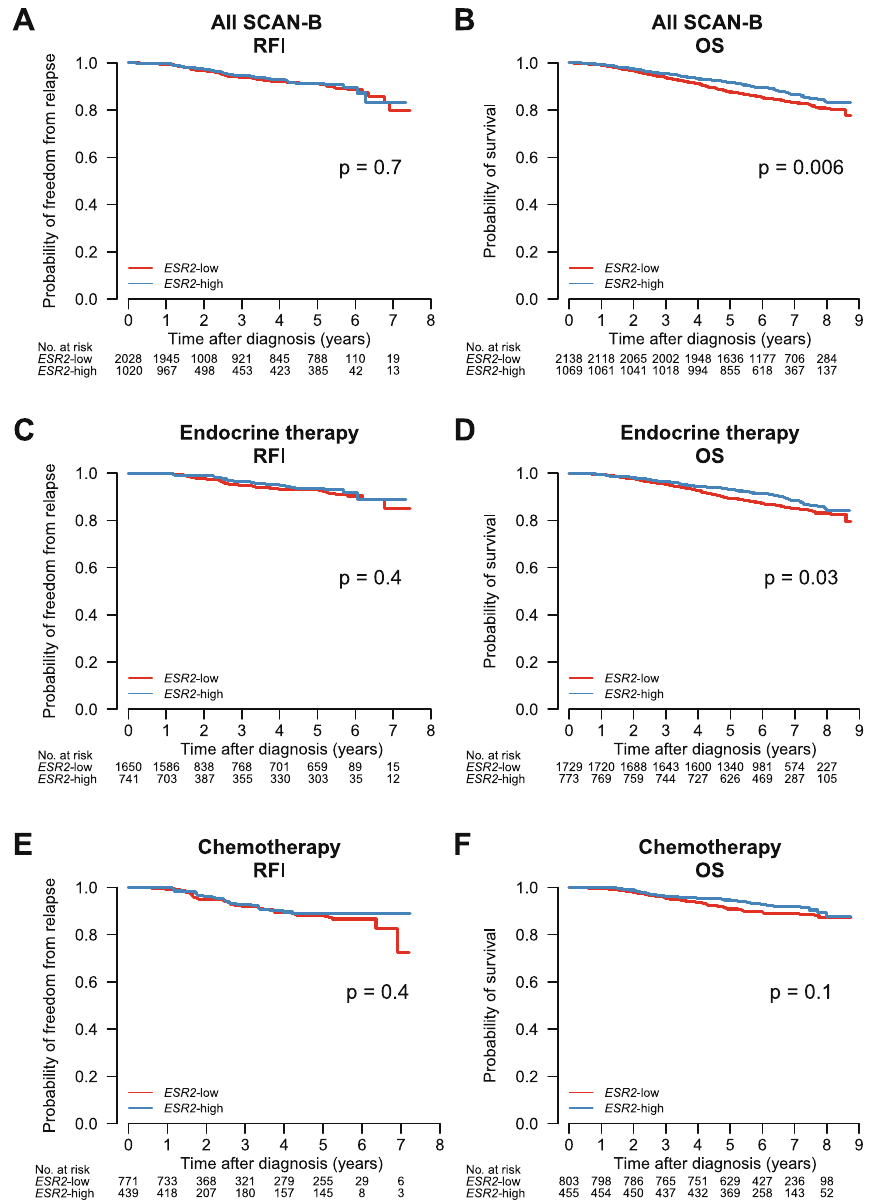
Figure 3. ESR2 expression and association to overall survival (OS) and relapse-free interval (RFI) in the full SCAN-B cohort ( A , B ), the endocrine-treated sub-group ( C , D ) and the chemotherapy-treated subgroup ( E , F